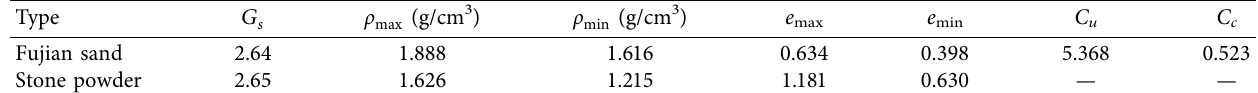
Figure 1: Grain size distribution curves of the sand and soil Table 1: Basic properties of the sand and fnes used in the test.